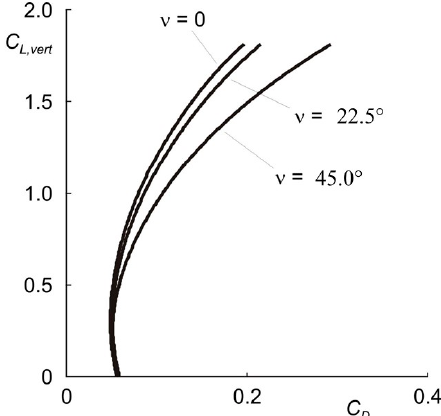
Figure 4. Drag polar showing relation between drag coefficient and lift coefficient acting in vertical direction.